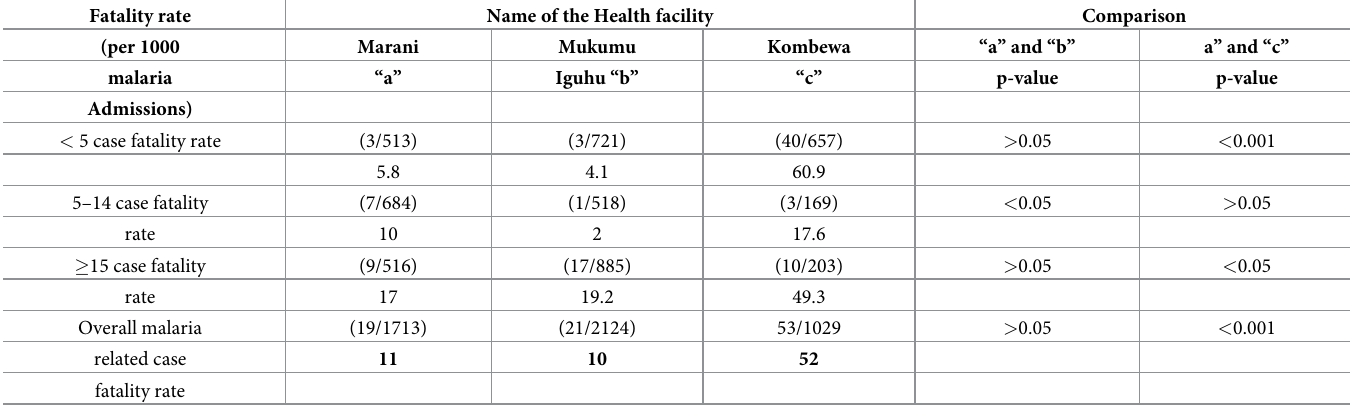
Table 5. Malaria related case fatality rates from three hospitals located in different infections transmission intensity in Western Kenya from June 2015 to August